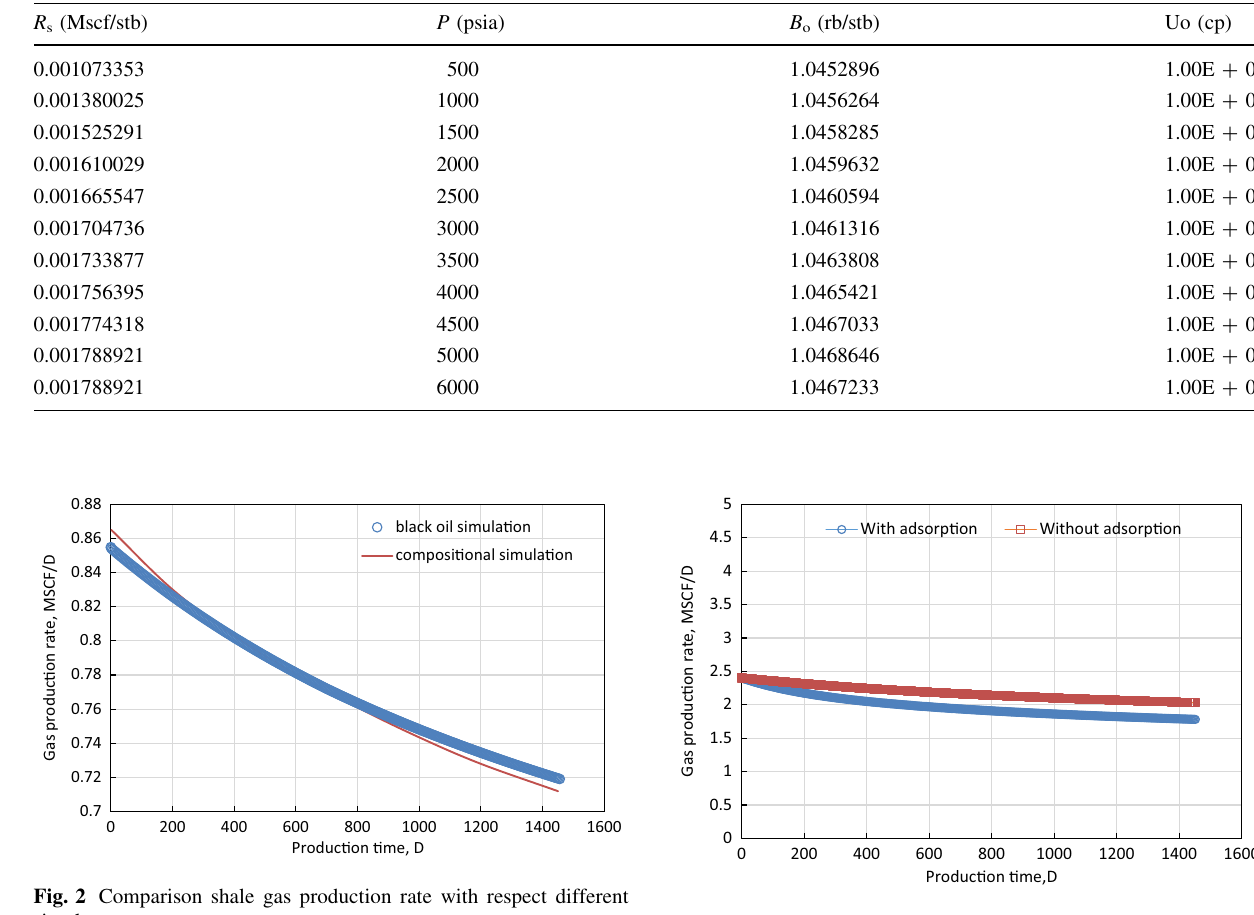
Table 2 Equivalent dissolved gas–oil ratio with amounts of gas adsorption (PVTO input values)